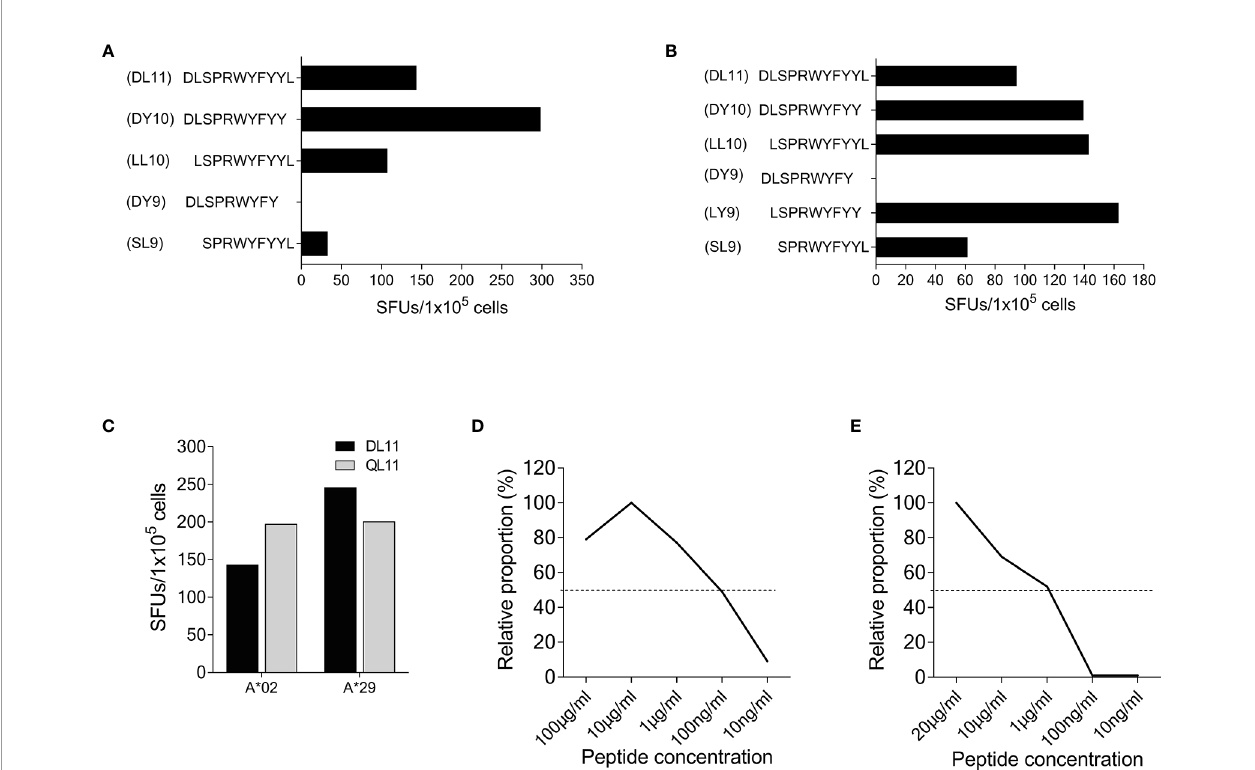
FIGURE 6 | The peptide SCoV-DY10 can be presented by A*02 and A*29. (A) Recognition of truncated peptides by the SCoV-DP15-speci fi c T-cell line from donor #26 in a g -IFN ELISpot assay. 1x10 5 T-cells were coincubated with 1x10 5 cells of the HLA-A*02 positive T2 cell line. T2 cells without peptide served as negative controls to assess for background, SFUs are shown after subtraction of background. (B) Presentation of peptides by an HLA-A*29-positive B-LCL. 1x10 5 SCoV- DP15-speci fi c T-cells from donor #26 were co-incubated with 1x10 5 cells of an HLA-A*29-positive B-LCL in a g -IFN ELISpot assay. B-LCLs without addition of peptide were used as negative (=background) controls. (C) 1x10 5 cells from the T-cell line #26 were incubated in a g -IFN ELISpot assay with either the SARS-CoV-2 peptide SCoV-DL11 or the corresponding OC43 peptide OC43-QL11 at a fi nal concentration of 20µg/ml. Shown are SFUs per 1x10 5 cells after subtraction of background reactions in wells with T-cell suspension without peptide. (D) Recognition of serial dilutions of peptide SCoV-DY10 by a SCoV-DP15-stimulated T-cell line from subject #15 (HLA-A*02,A*29;B*13,B*44,C*06,C*16) in a g -IFN ELISpot assay. Peptides were added directly to 1x10 5 cells each of the T-cell line. The half- maximal (50%) peptide concentration is indicated by the dashed line. T2 cells without peptide served as negative controls. (E) Recognition of serial dilutions of peptide SCoV-DY10 presented by the A*02-positive T2 cell line (HLA-A*02,B*51,C*01). After incubation with peptides at a fi nal concentration of 20µg/ml, T2 cells were washed thrice and added to the T-cell line from donor #26 (HLA-A*02, A*29, B*15, B*58, C*03, C*07) in a g -IFN ELISpot assay. 1x10 5 T2 cells and 1x10 5 T-cells were used per well, T2 cells without peptide were used to determine background reactions. Raw data for (D, E) are shown in Supplementary Table S2